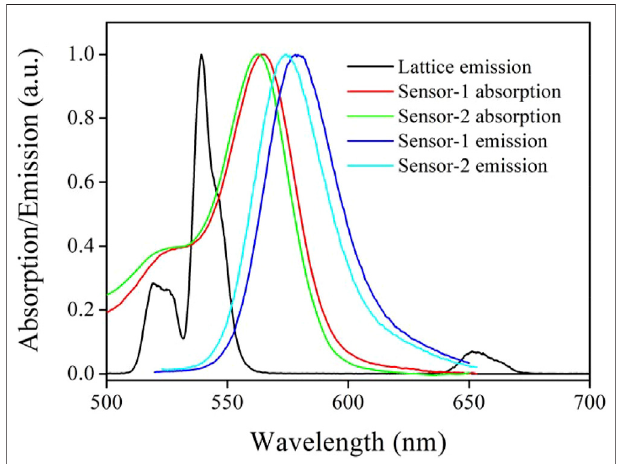
FIGURE 4 | Emission and absorption spectra of our excitation lattice (in PBS, pH = 7.0, 5 mg in 10 ml, λ ex = 980 nm) and two chemosensors (in CH 2 Cl 2 , 10 μ M, with 1 eq. of Cys).